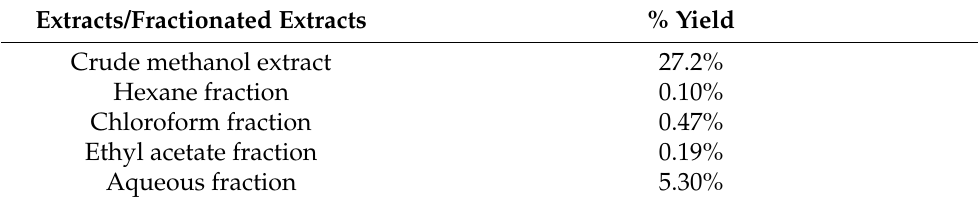
Table 1. Yield (%) of crude methanol extracts and fractions of C. minima .